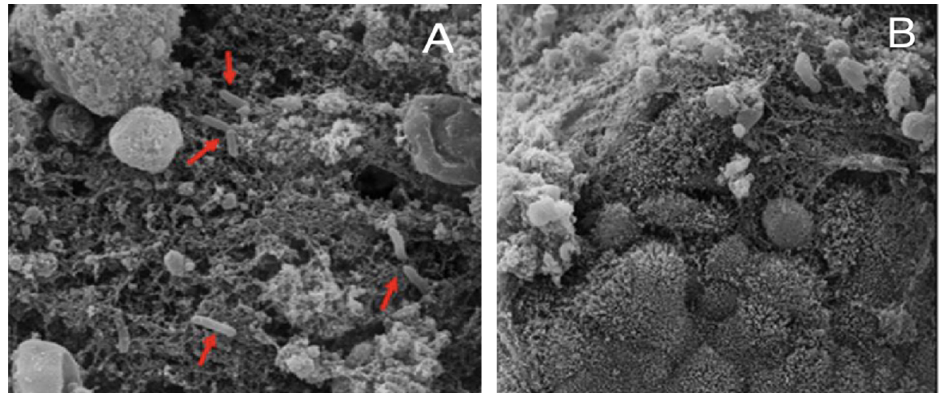
Figure 6. Scanning Electron Microscopy (SEM) of the small intestine in the inoculated rabbit ileal loops model, 12 h post inoculation of the AB170 strain. ( A ) Destroyed villi and presence of bacilli in the extracellular matrix (Red arrows). ( B ) Negative control. Intestinal crypts are preserved.